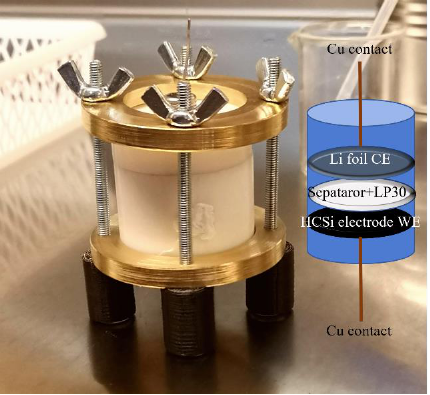
Figure 1. “Home-made” 2-electrode system for electrochemical measurements.